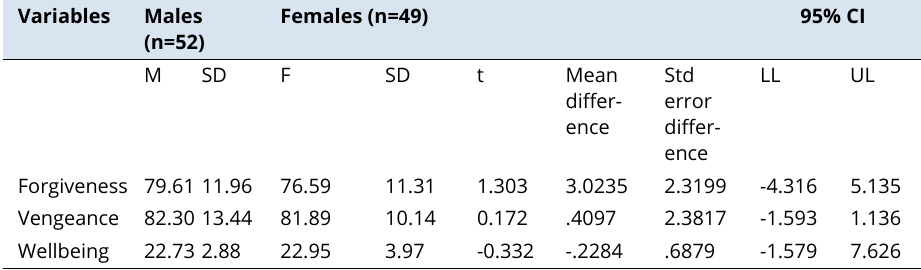
Independent t-test values for Gender difference